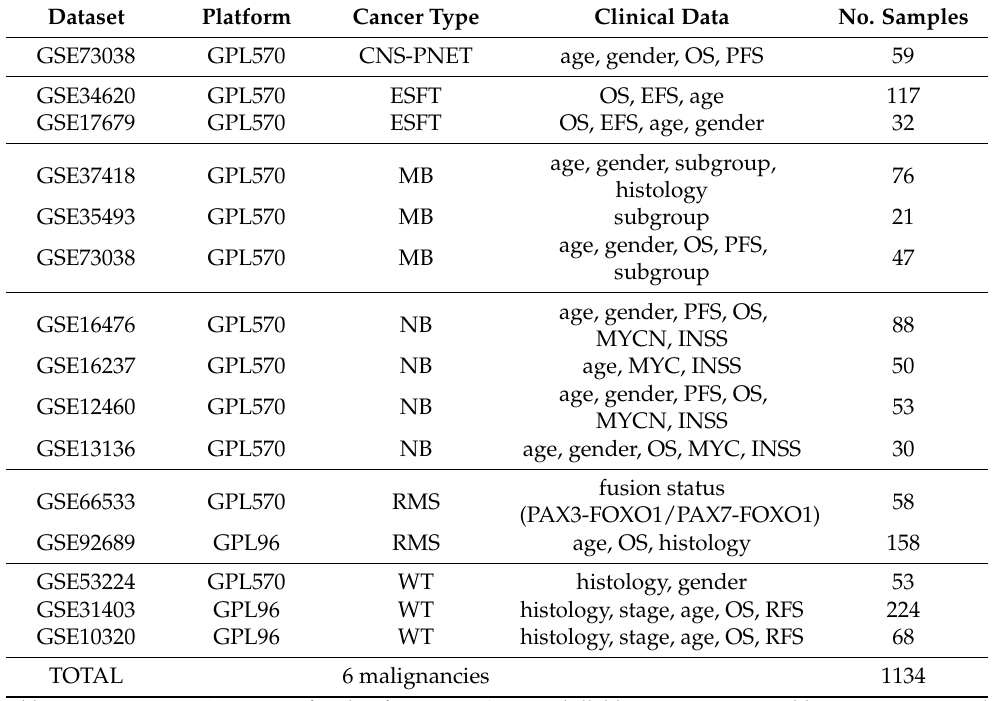
Table 1. Six pediatric small round blue cell tumor types. The cohort was restricted to Affymetrix plat- forms (HGU133Plus2 [GPL570] and HGU133A [GPL96]). Clinical–pathological data were retrieved from the Gene Expression Omnibus (GEO) and published